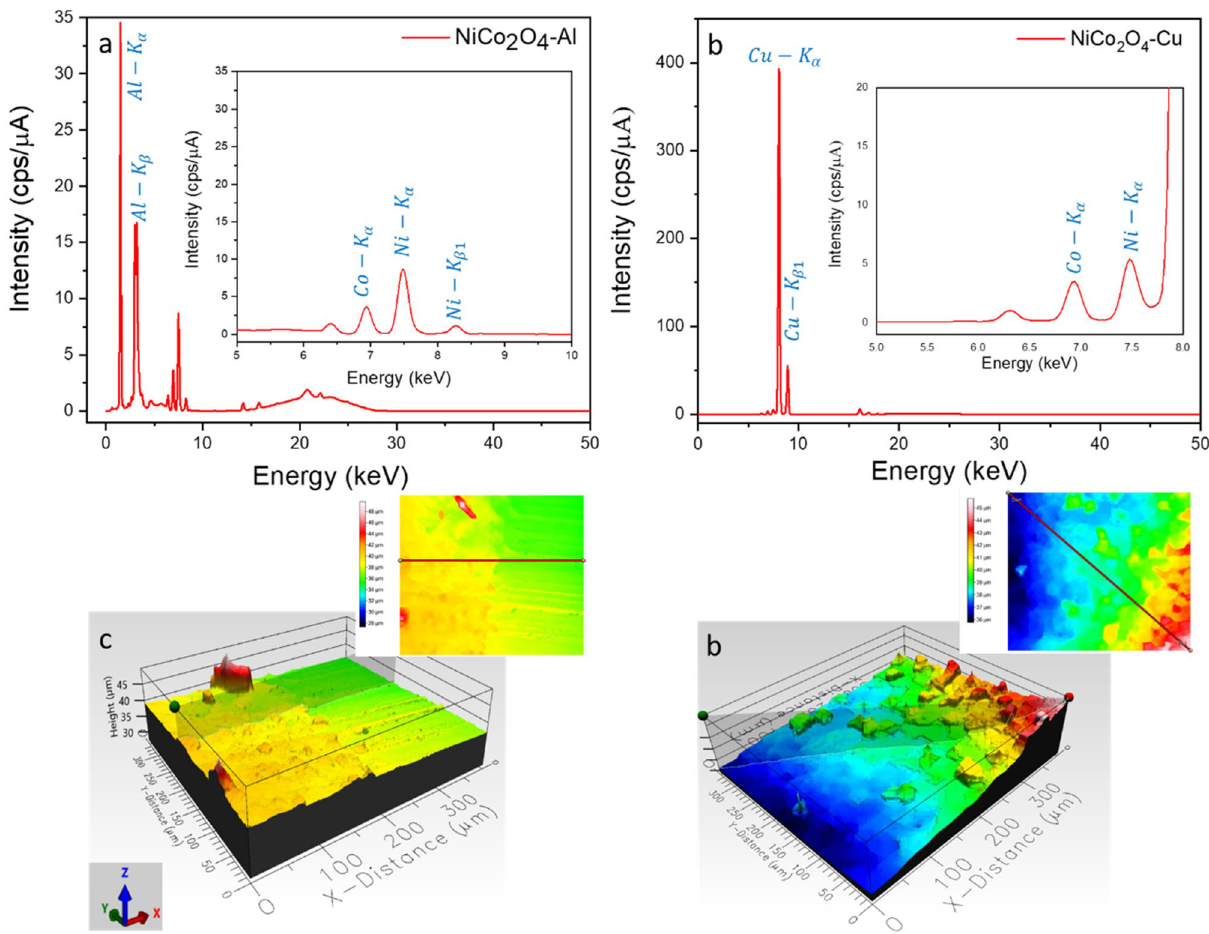
Fig. 5 X-ray fluorescence profile of NiCo view respectively (inset image: 2D